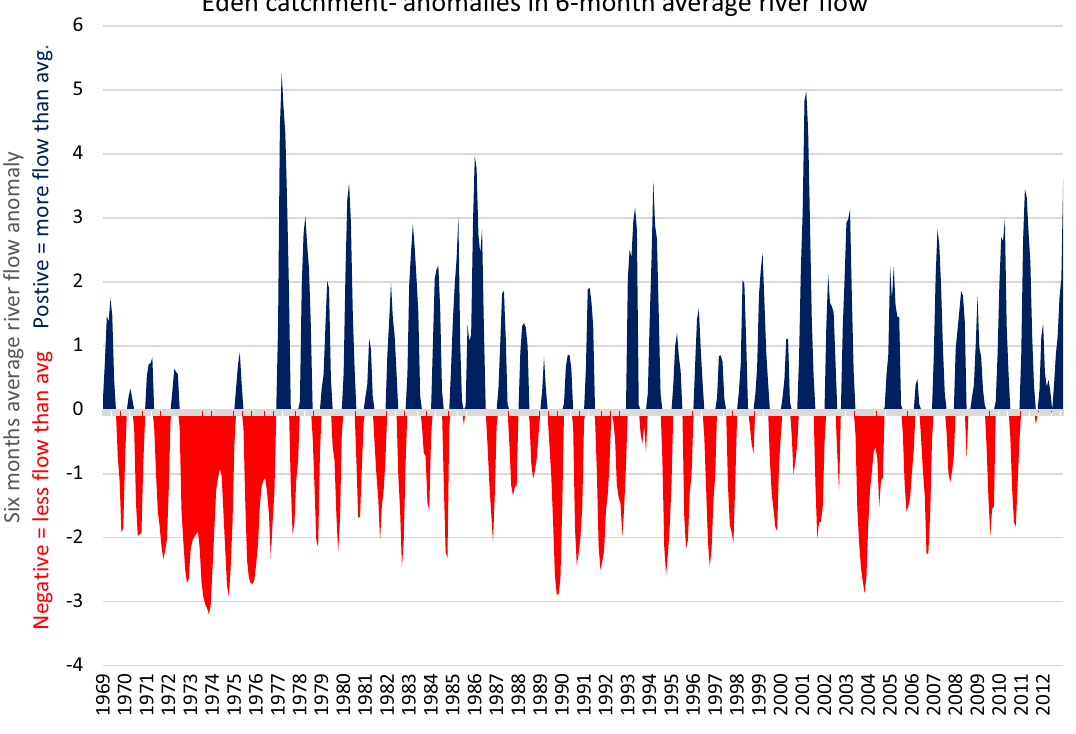
Fig. 4 Anomalies in six-month average river flow for Eden at Kemback for the 1969–2012